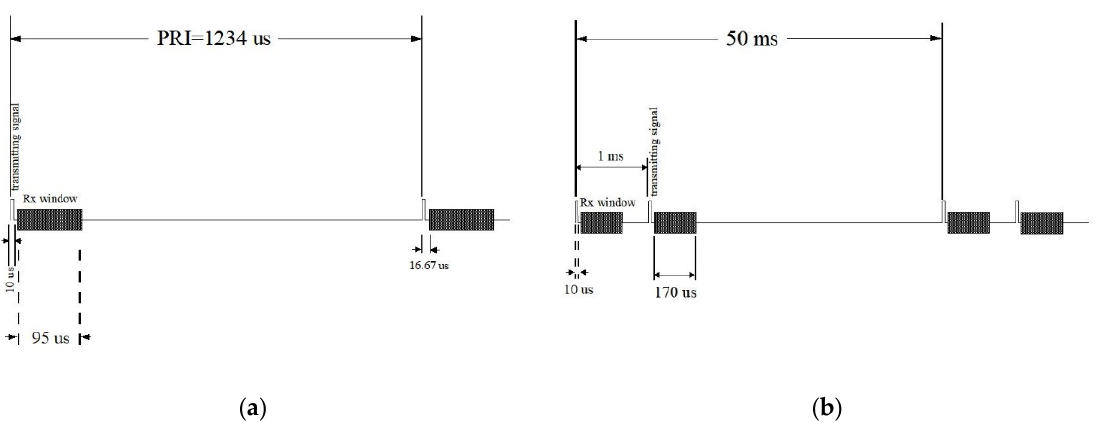
Figure 3. ( a ) Time scheme of HFSS; ( b ) Time scheme of ADM in the ground experiment.